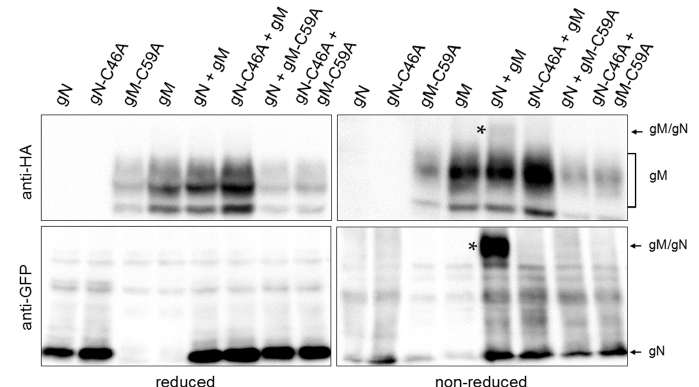
Figure 3. HSV-1 gN forms a covalent interaction with gM by disulphide bonding between C59 of gM and C46 of gN. To determine whether C59 of gM and C46 of gN form a disulphide bridge, site- directed mutagenesis was performed to replace cysteines (C) by alanines (A). Plasmids encoding gN–